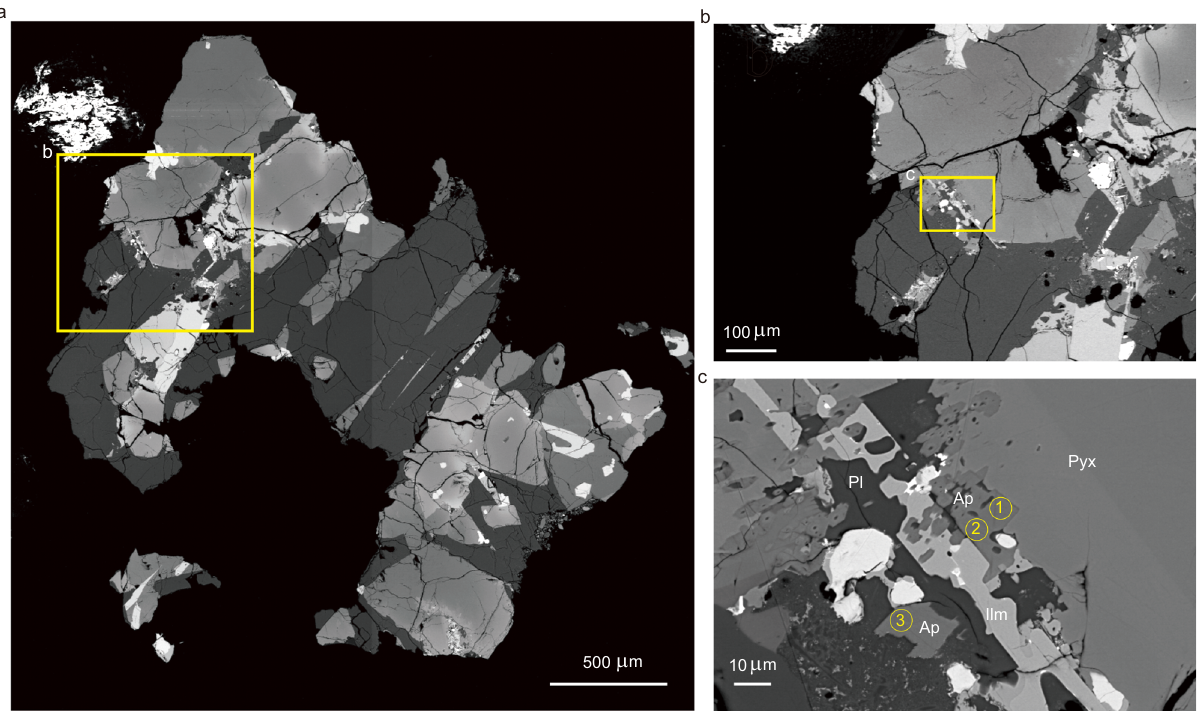
Fig. 2 Back-Scattered Electron (BSE) images of representative apatite grains in a basalt clast (sample: CE5C0000YJYX042GP). The basaltic clast is mainly composed of pyroxene, plagioclase, and olivine, but a considerable quantity of apatite and ilmenite are also found. Panel b is a zoomed-in image of ( a ), and panel c is a zoomed-in image of ( b ), the positions of Raman and EPMA measurements are marked with yellow circled numbers in panel c . Pyx- pyroxene; Pl-plagioclase; Ap-apatite;